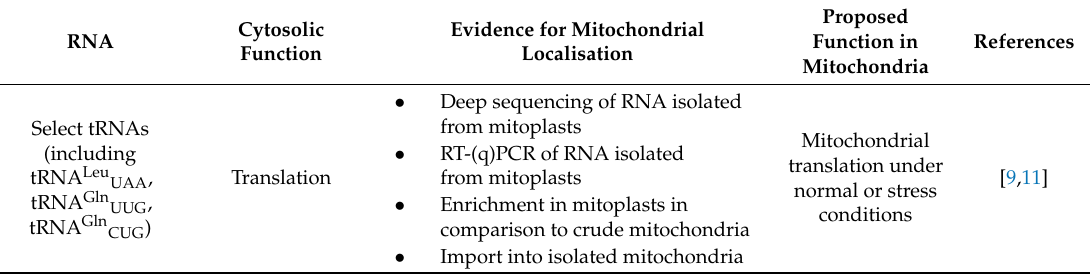
Table 1. Nuclear-encoded RNA species found in the human mitochondria.